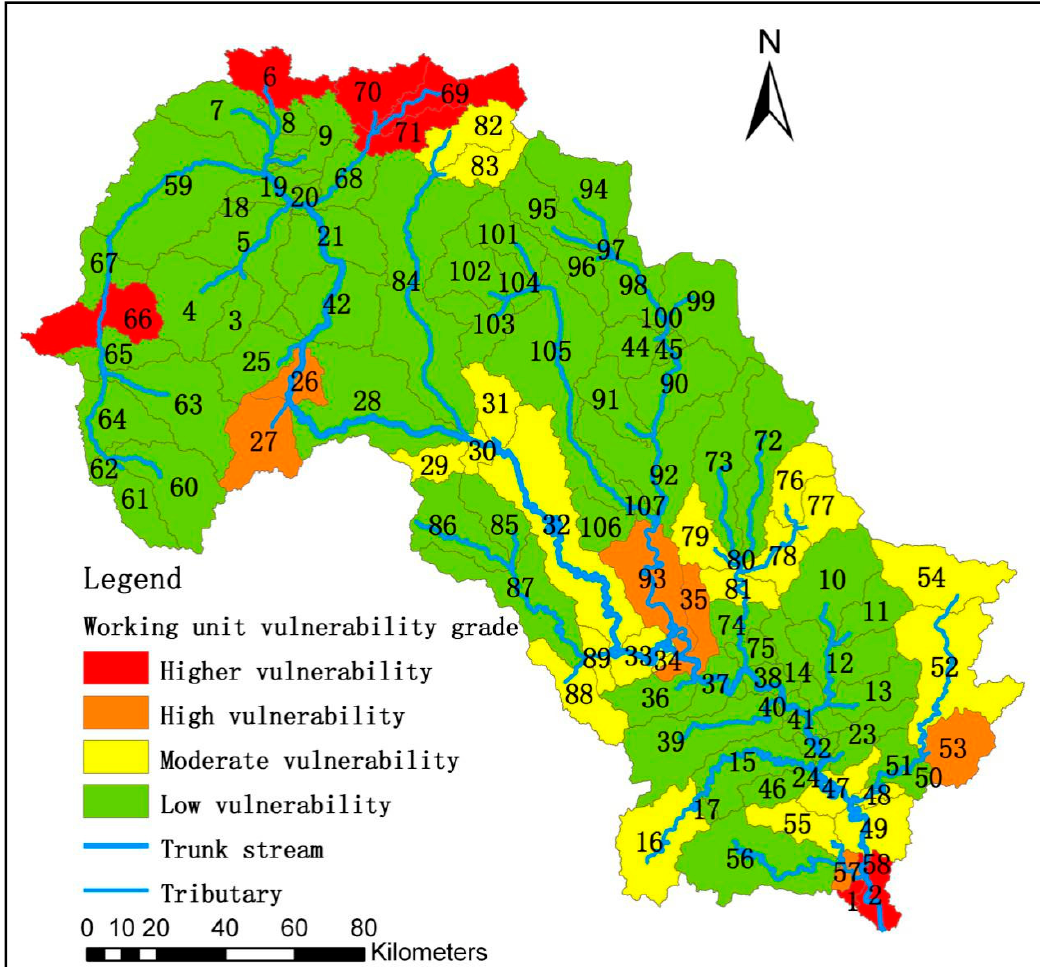
Figure 10. Working units vulnerability grade distribution map.